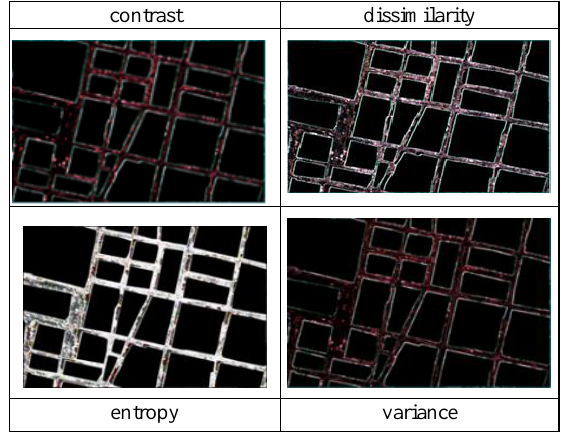
Fig 4. Some of the texture descriptors extracted from satellite images for classification After extraction of pertinent descriptors, the image is classified into the mentioned six classes. The results of the classification are delineated in Fig.5.